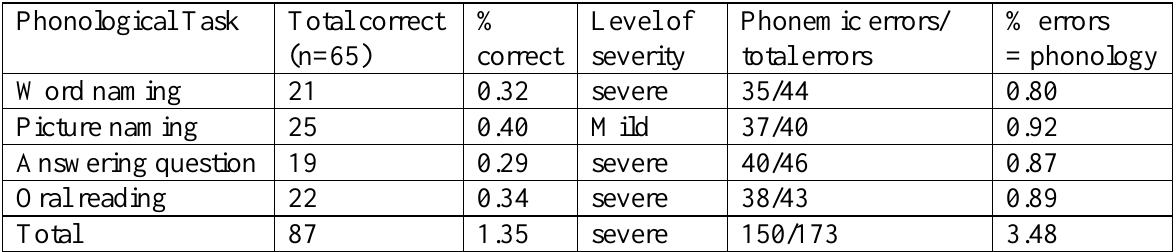
Table 4. KW’s Performance on the Set of Phonological